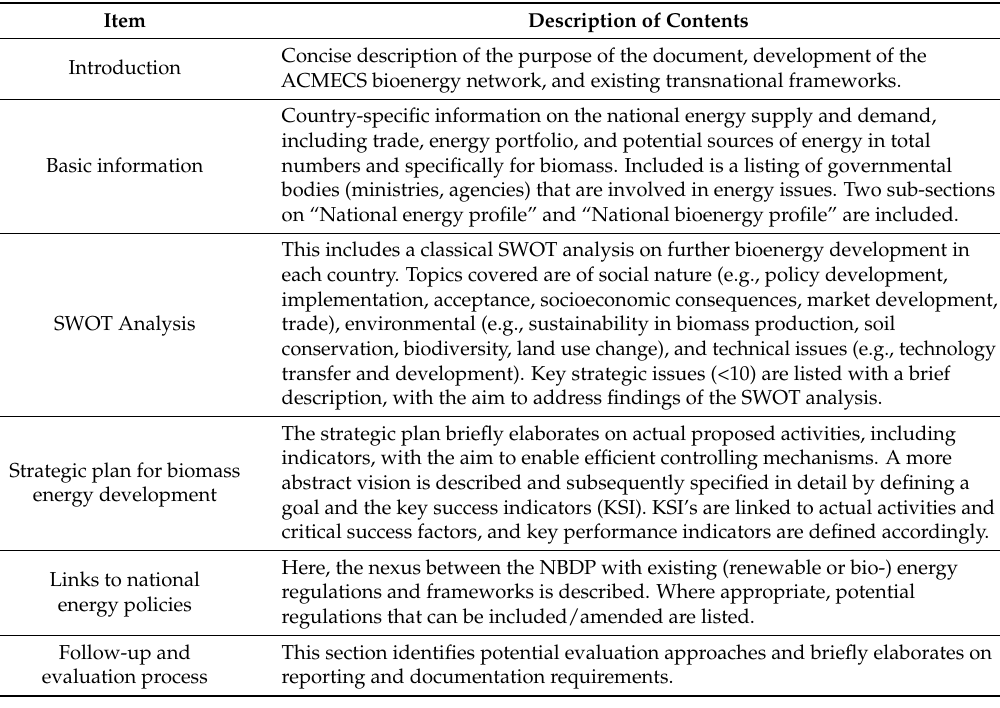
Table 2. Basic structure of the National Bioenergy Development Plan (NBDP). Items are presented according to their sequence in the